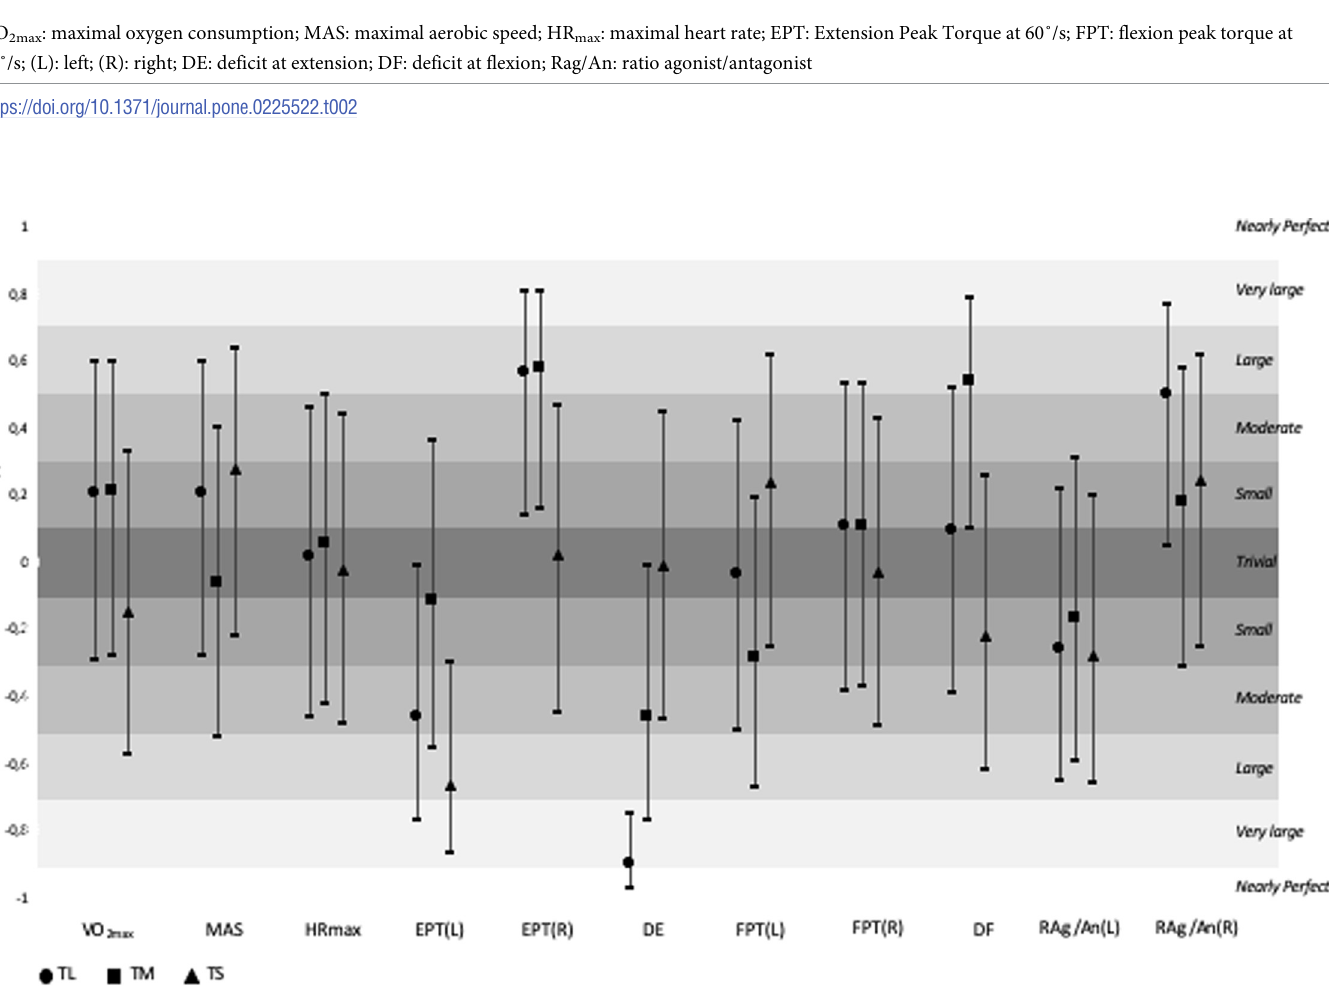
PLOS ONE | https://doi.org/10.1371/journal.pone.0225522 December4,